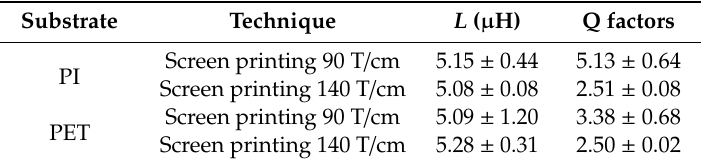
Table 3. Inductance ( L ) and quality factor (Q) at 13.56